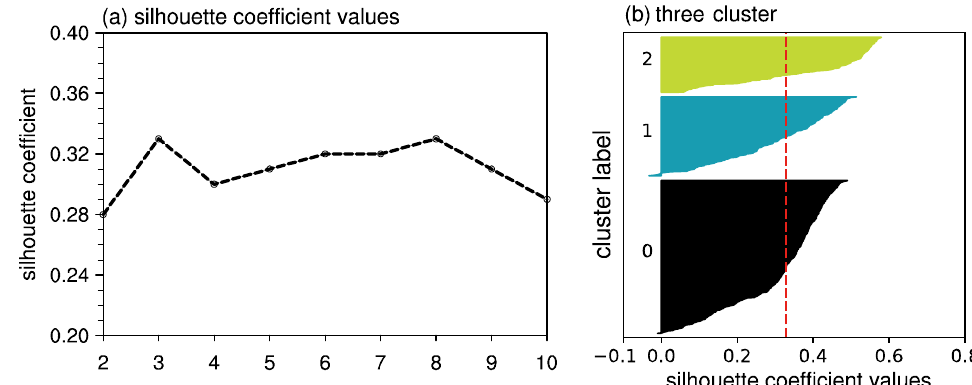
Figure 3. ( a ) Silhouette coefficients in clusters 2 – 10 and ( b ) Silhouette coefficients (red dashed line) and each sample number in three cluster.